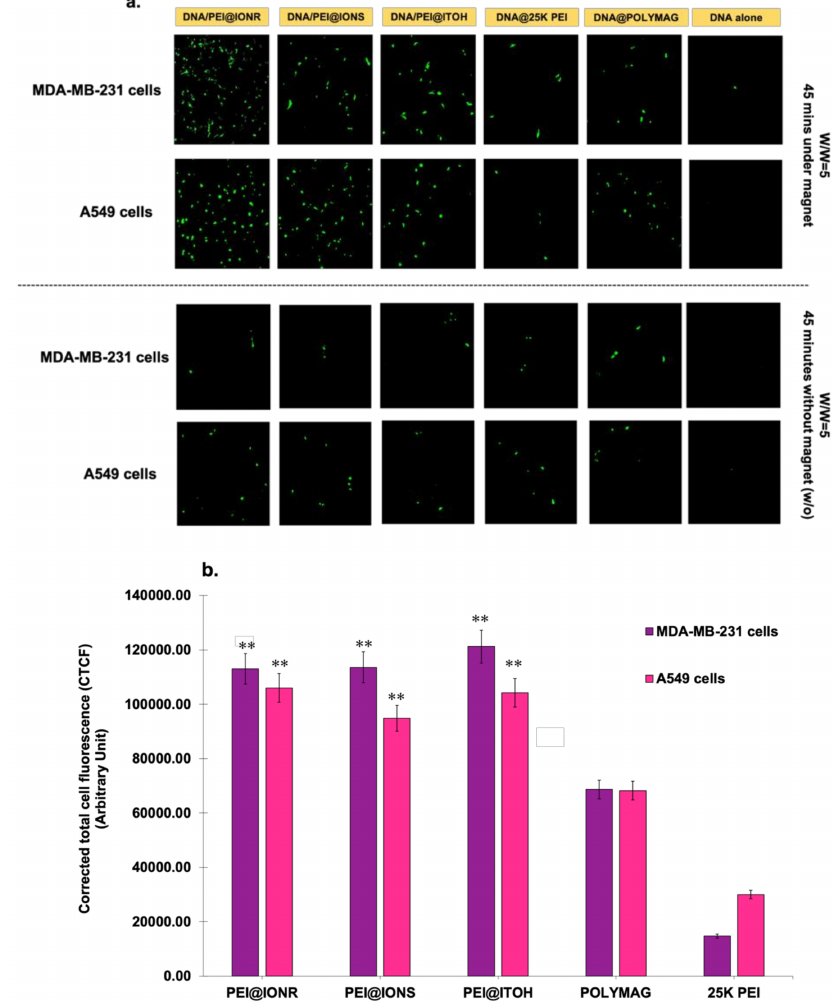
Figure 3. Transfection efficiency study, involving the delivery of plasmid DNA, using PEI@IONPs. ( a ) Expression of green fluorescent protein (GFP), observed through fluorescence microscope in MDA-MB-231 and A549 cell lines transfected with GFP-tagged miRNA34a intact pDNA using PEI@IONPs and incubated with and without (w/o) a static magnet, for 45 min, at a DNA/IONP weight ratio of 5 ( W/W = 5), compared with PolyMag as a positive control. ( b ) Corrected total cell fluorescence (CTCF) of MDA-MB-231 and A549 cells calculated using ImageJ software. The results are represented as mean value ± standard deviation ( n = 3, ** p <